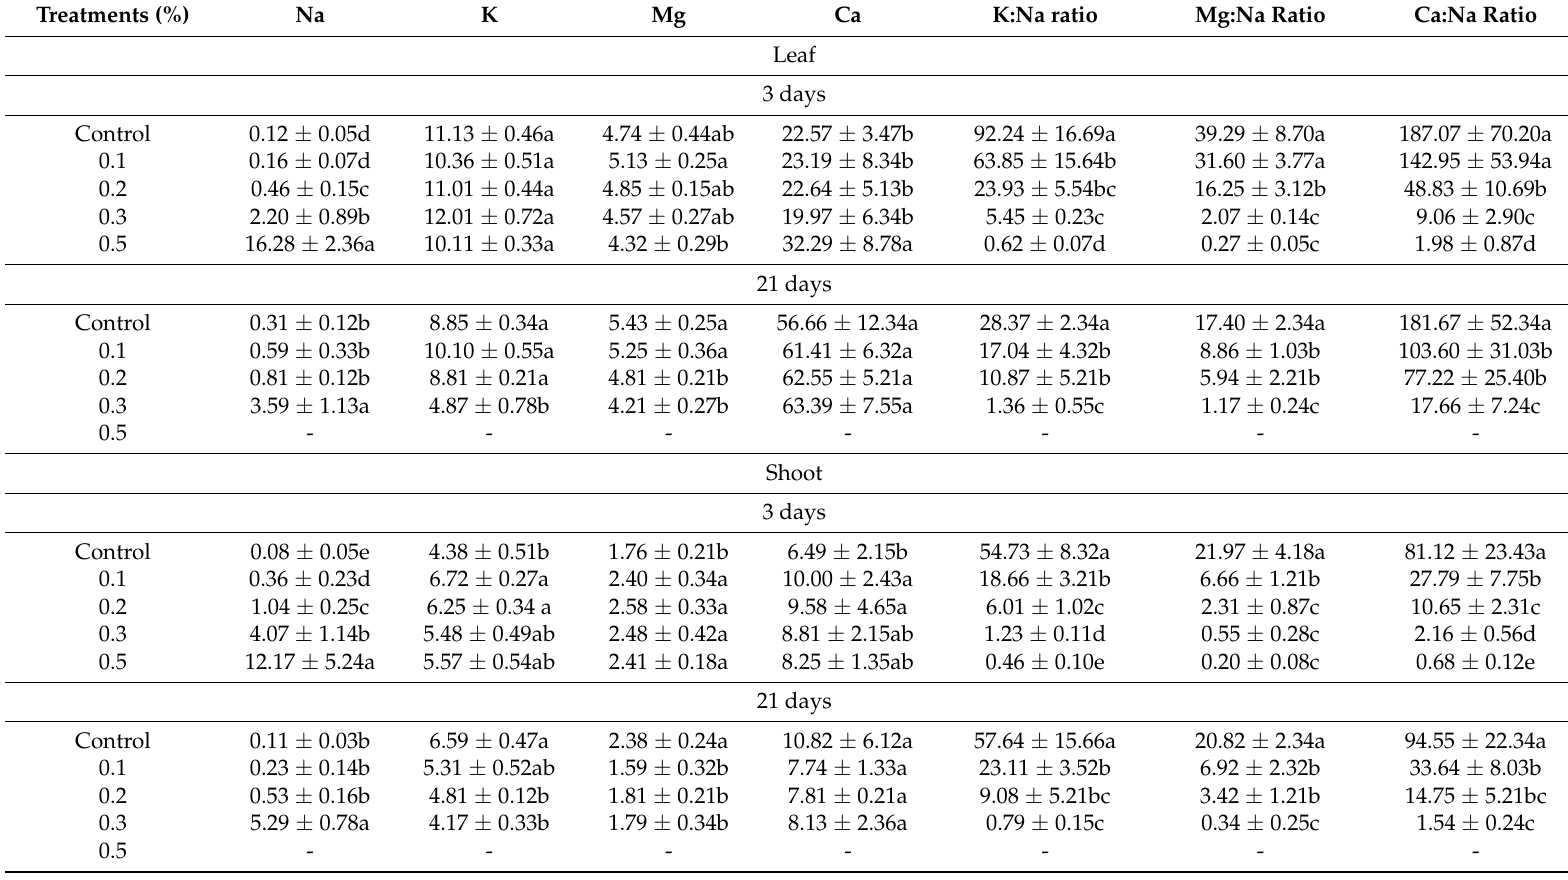
Table 6. Concentrations of Na, K, Mg, and Ca in leaves, shoots, taproots, and lateral roots of mulberry plants (mg g − 1 DW) grown under various levels of soil salinity under greenhouse conditions. Data in each column with the same letter are not significantly different ( P = 0.05). Treatments